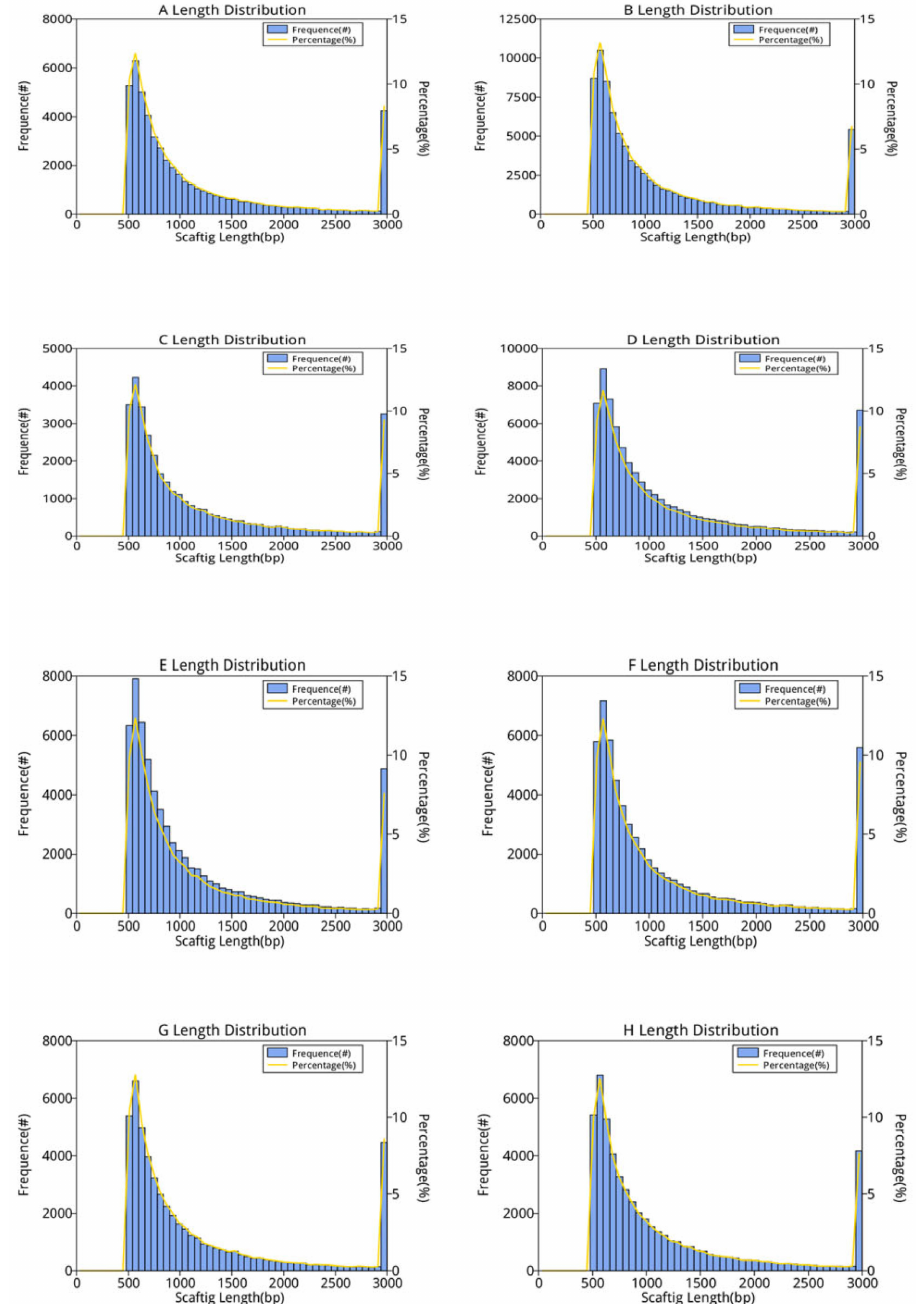
Figure 1. Scaftig length distribution statistics of each sample ( ≥ 500 bp). The first vertical axis (Frequence (#)) represents the number of scaftigs; the second vertical axis (Percentage (%)) represents the percentage of the number of scaftigs; the horizontal axis represents the length of